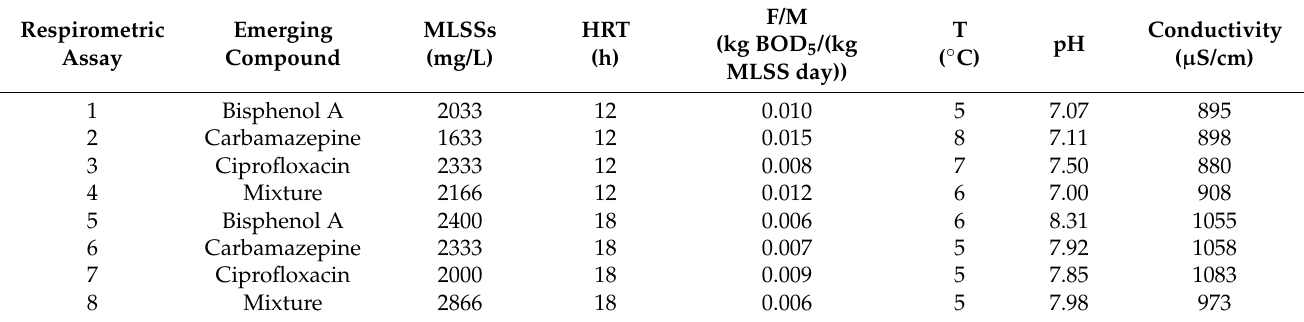
Table 3. Design of experiments.